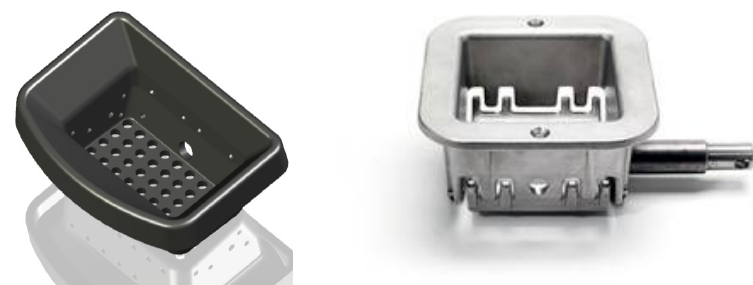
Figure 1. On the left: burner pot model adopted in stoves A; on the right: burner pot model adopted in stoves